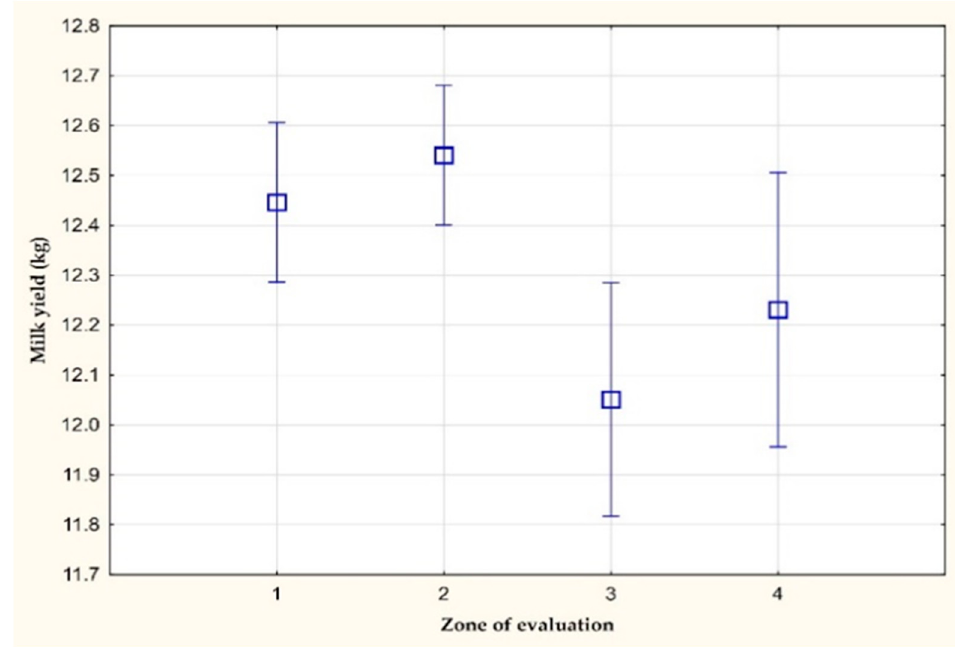
Figure 1. The amount of milk yield per milking (kg) on farm B.